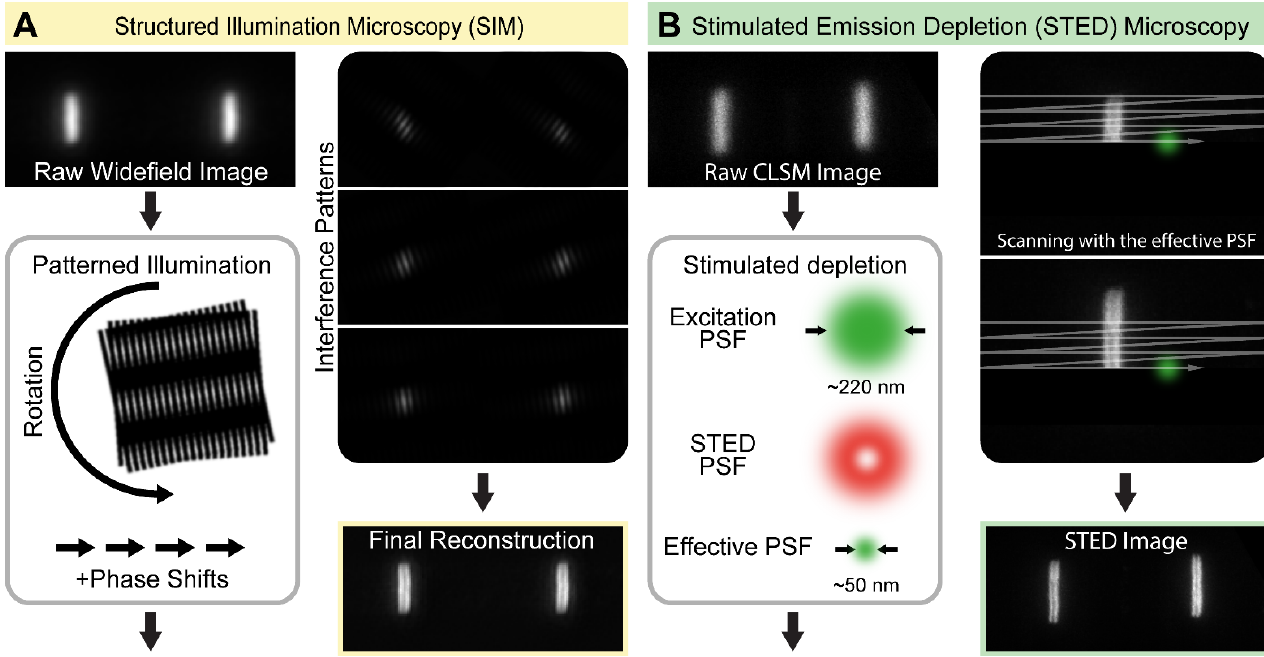
Figure 2. The concept of structured illumination microscopy (SIM) and stimulated emission depletion (STED) microscopy. ( A ) SIM is a widefield microscopic approach that relies on generating interference patterns (moiré fringes) in the plane of imaging through illuminating the samples with a periodic pattern. Images are acquired in multiple orientations and angles, and the high-resolution image is reconstructed computationally. ( B ) STED microscopy is a point scanning approach that relies on generating a subdiffraction-sized focal point in the sample plane. It is achieved by inducing a stimulated emission with a doughnut-shaped STED beam that is spatially overlaid with a regular excitation beam. The effective PSF, and therefore the resolution, is tuned by the intensity of the depleting STED laser. The sample is scanned by the co-aligned beams, which provides an image with a significantly improved resolution.